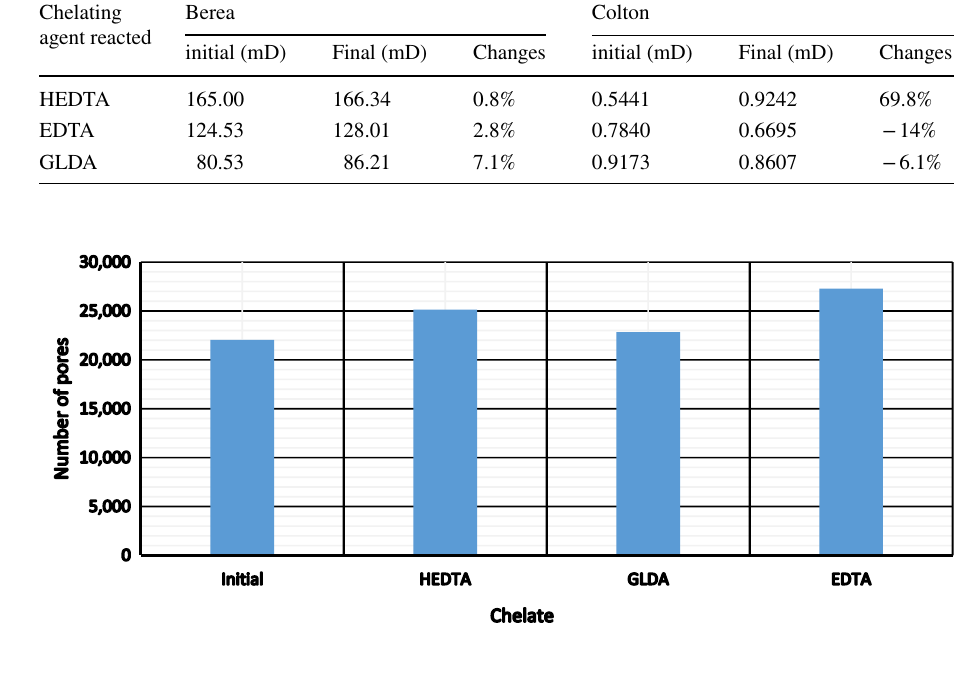
Chelating agent